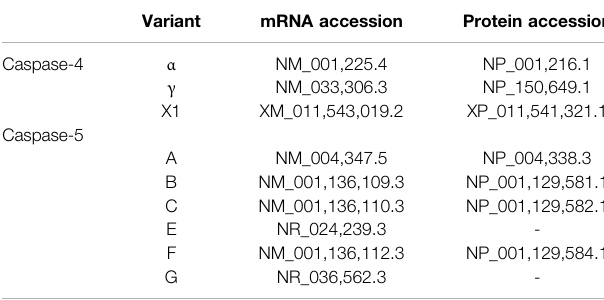
TABLE 1 | NCBI accession numbers for Caspase-4 and -5